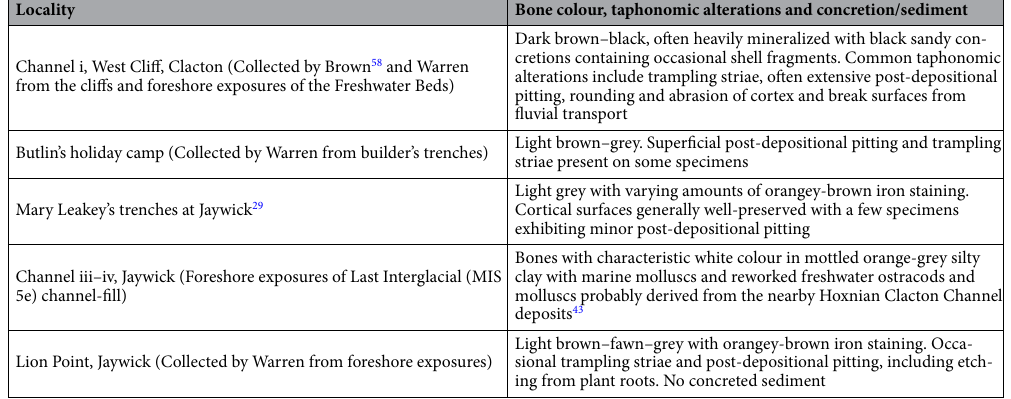
Table 1. Typical preservation characteristics of bones from different localities associated with Pleistocene channel deposits at Clacton and Jaywick